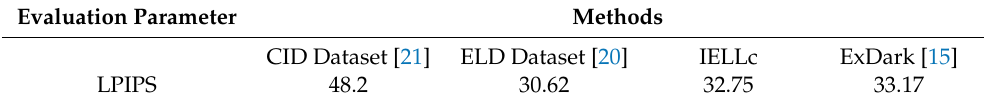
Table 5. LPIPS result of different datasets used in the MSR-MIRNeT model. Evaluation